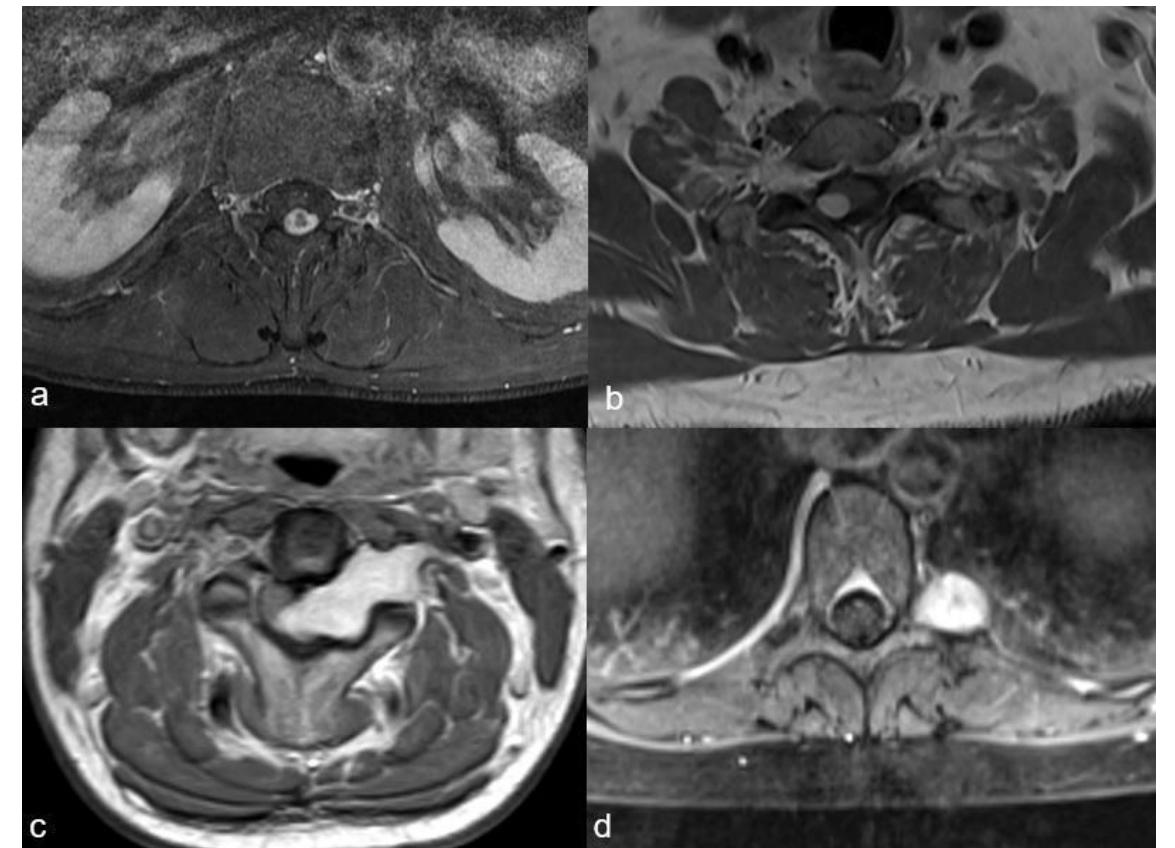
Figure 1. The four schwannoma localisations as described by Sun et al.: ( a ): exclusively intradural localisation (I), ( b ): intradural localisation with extradural extension to the nerve root foramina, but restricted to the spinal canal (II), ( c ): intradural tumour extending to the extraforaminal region (III), ( d ): localisation completely outside of the foramina (IV).